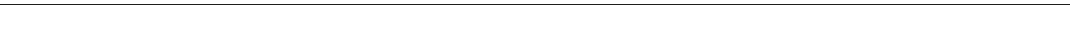
Fig. 2 FAP + HO-1 + macrophages represent a wound healing response phenotype. a Heat map of raw gene expression values from splenic-derived M-CSF basal macrophages (M0) and 4T1 TAMs ( n = 4 per condition). b Gene ontology enrichment analysis of M0 vs. 4T1 TAMs, showing selected pathways of interest that were signi fi cantly enriched. c – e Skin sections stained using DAPI (nuclei, blue) and antibodies against F4/80 (green), FAP (yellow) and HO-1 (red). c Image of healthy skin taken using a ×40 objective. d Image of wounded skin taken using a ×4 objective 6 days post wounding (pw). e High magni fi cation image of example F4/80 + FAP + HO-1 + cells found in the granulation tissue; arrow marks cell of interest. f , g Quanti fi cation of F4/80 + cells normalised to area ( f ) and percentage of F4/80 + cells that co-expressed FAP and HO-1 ( g ) as an average of multiple fi elds of view in the healthy dermis and in the respective area of the wound environment ( n = 6 mice per condition). Statistics were performed to compare each condition to healthy dermis. h Volcano plots showing changes in cytokine gene expression in skin in response to wounding using a 1 mm punch biopsy needle 28 . Genes marked in red represent cytokines most highly induced 12 h (left) and 24 h (right) pw ( P ≤ 0.05; Log 2 (fold change) ≥ 4). i Expression levels of the indicated genes ( h ) over the duration of the wound response to a 1 mm punch biopsy needle 28 . j mRNA expression of the indicated cytokine genes relative to the housekeeping gene Tbp in healthy mammary gland ( n = 6) and late stage (>20 day post inoculation) 4T1 (blue) and E0771 (black) tumours ( n = 6). k M0- subtracted gene expression from 4T1 TAMs, displaying selected genes of interest ( n = 4). Bar charts represent mean + s.d. * P < 0.05, ** P ≤